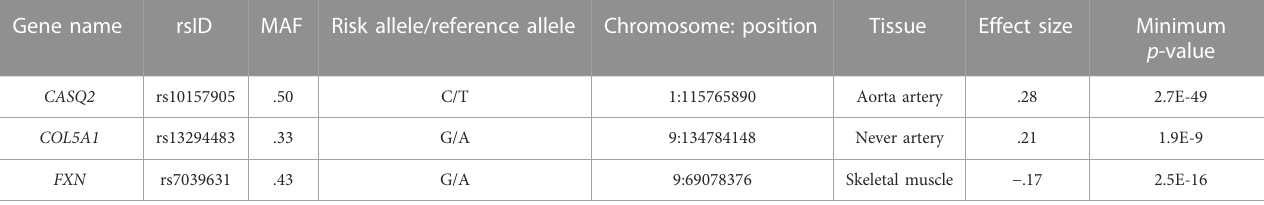
TABLE 4 Overview of expression quantitative trait loci (eQTL) effects related to center ventricular